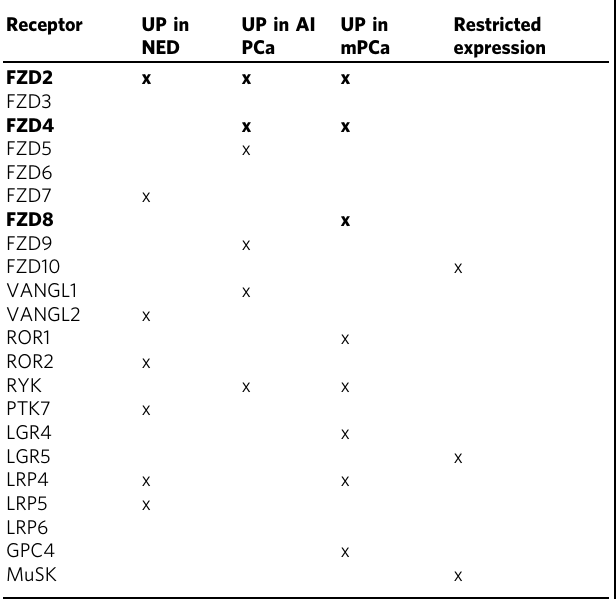
Table 1 Wnt receptor expression in prostate cancer cell lines Receptor UP in mPCa